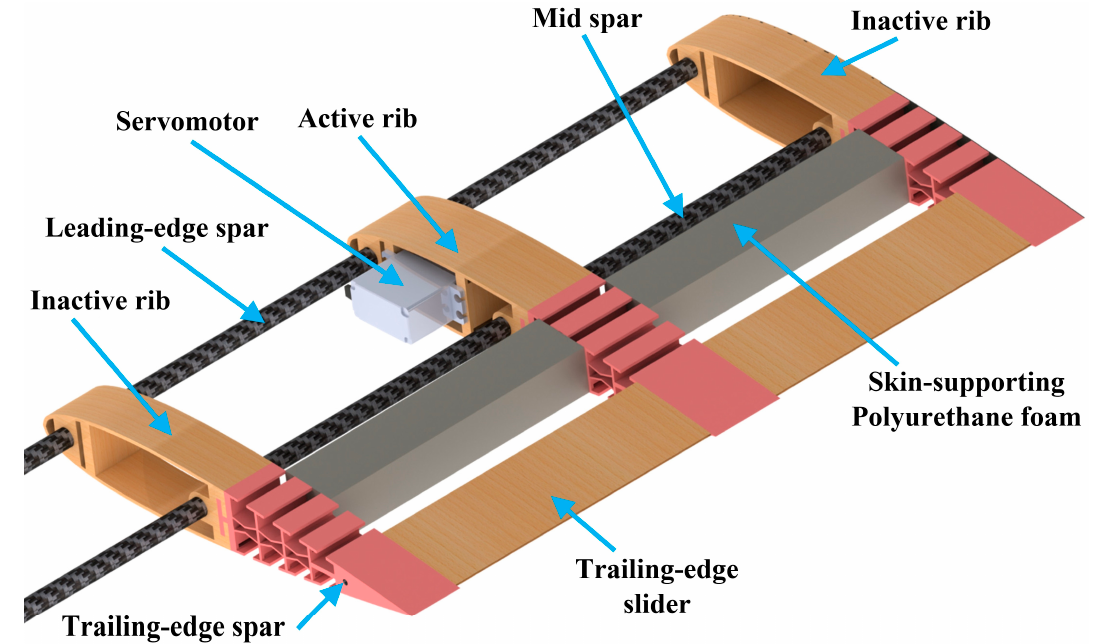
Figure 9. MM-3’s horizontal stabilizer .